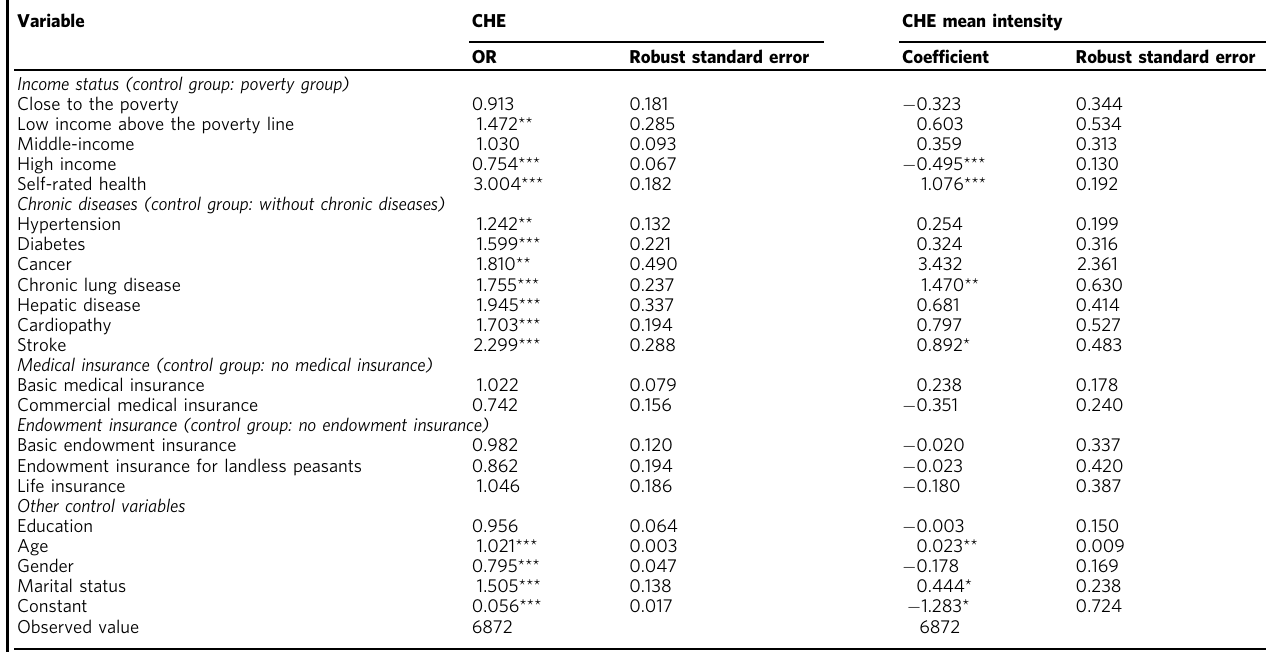
Table 4 Regression results of Catastrophic health expenditures (CHE).